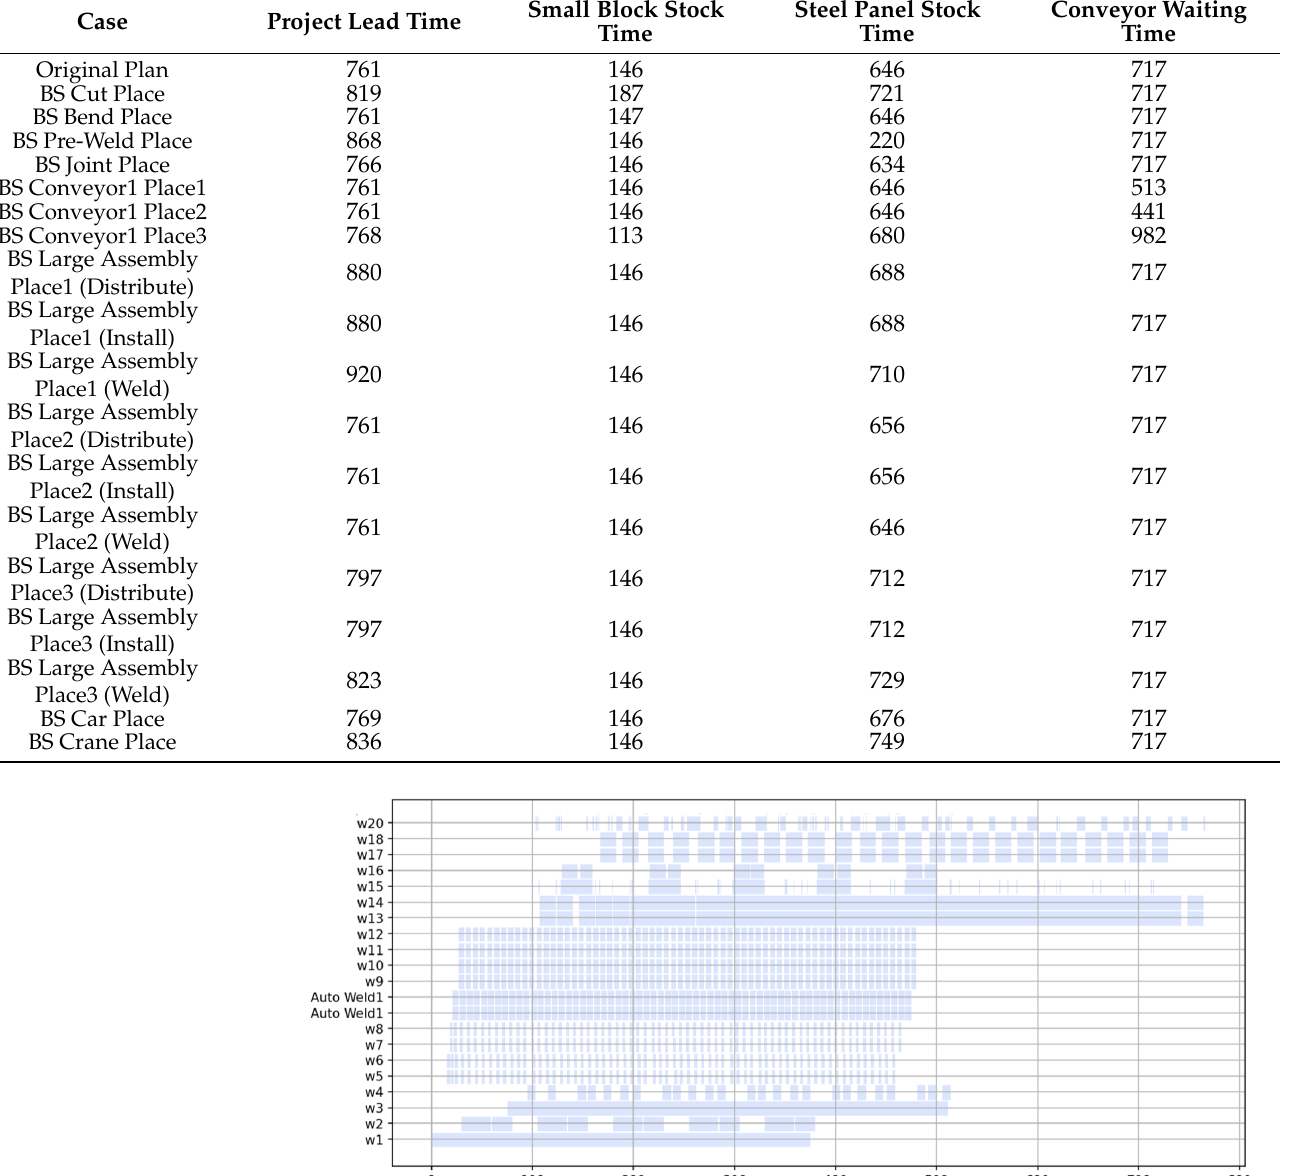
Table 4. Bottleneck Evaluation Results.